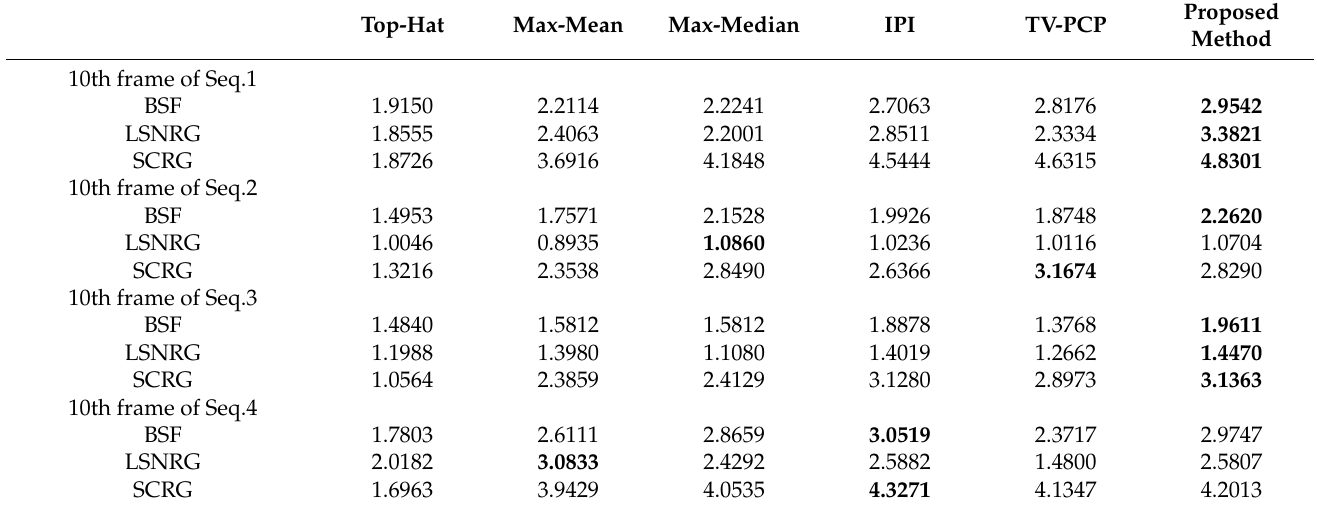
Table 3. Quantitative comparison of six methods for the images of Sequence